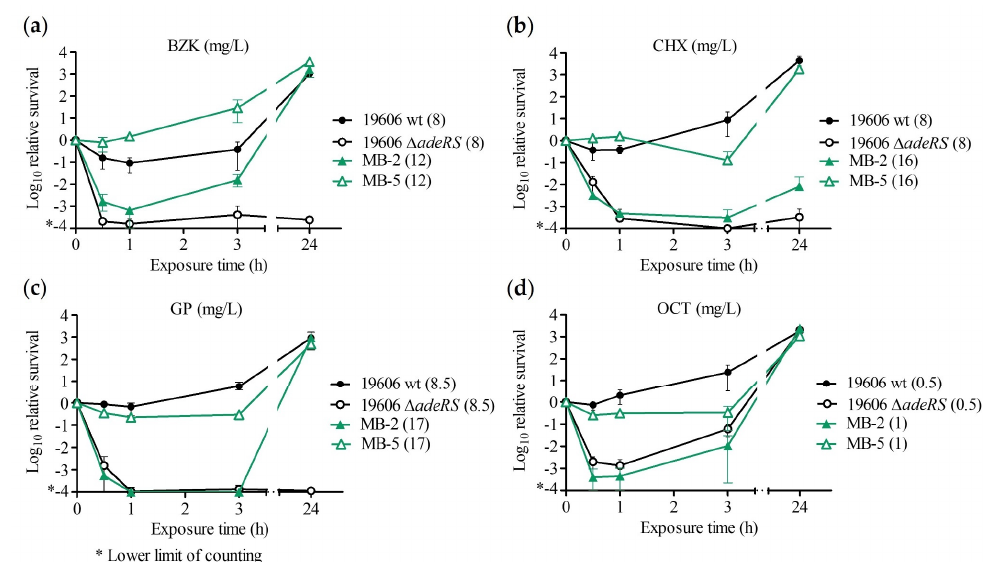
Figure 1. Impact of adeABC expression for laboratory strains A. baumannii ATCC 19606 and A. baumannii 19606 ∆ adeRS ( adeABC not expressed) and for clinical strains A. baumannii MB-2 and A. baumannii MB-5 ( adeABC overexpressed) in the time–kill assay. Time–kill curves of ( a ) benzalkonium chloride (BZK), ( b ) chlorhexidine digluconate (CHX), ( c ) glucoprotamin (GP), and ( d ) octenidine dihydrochloride (OCT). Tested concentrations (mg/L) written in parentheses. Error bars represent the range from three independent experiments.